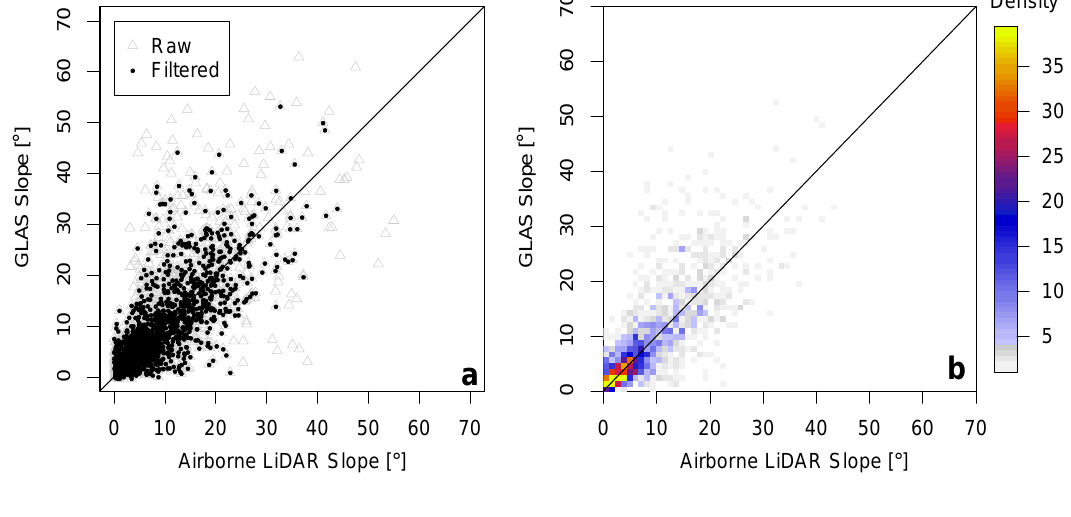
Table 4. Model performance statistics for ALS-, ISM- and SRTM-derived slope information. N = sample size, R 2 = square of Pearson correlation coefficient, p of no correlation (significance), D = Kolmogorov–Smirnov statistic [46], F predictions within a factor of two of observed values, F mean square